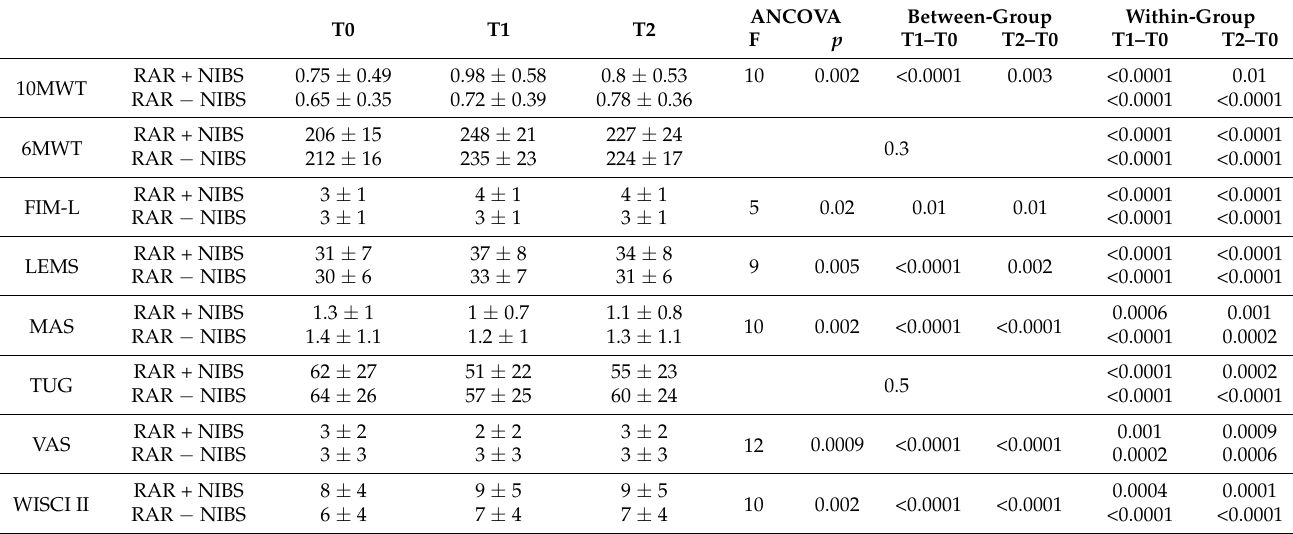
Table 2. Outcome measures and statistical